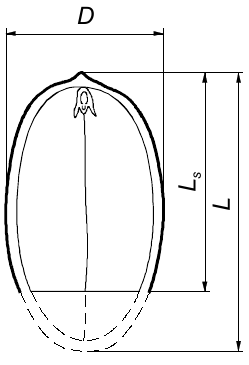
Figure 1. Acorn dimensions: D —diameter, L, L s —length before and after scarification. The length and diameter of acorns were measured with a caliper to the nearest 0.02 mm. Acorn diameter was determined as the average of two measurements performed at the widest point, perpendicular to the longitudinal axis. Acorn mass was determined with the Hornady 1500GR Bench Scale (Hornady ® , Grand Island, NE, USA) to the nearest 0.01 g.